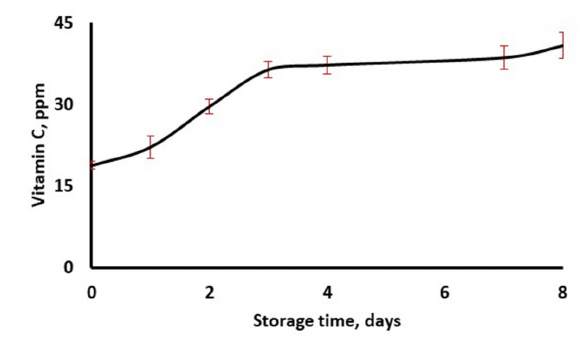
Figure 5: Leakage of vitamin C to the liposome medium in 8